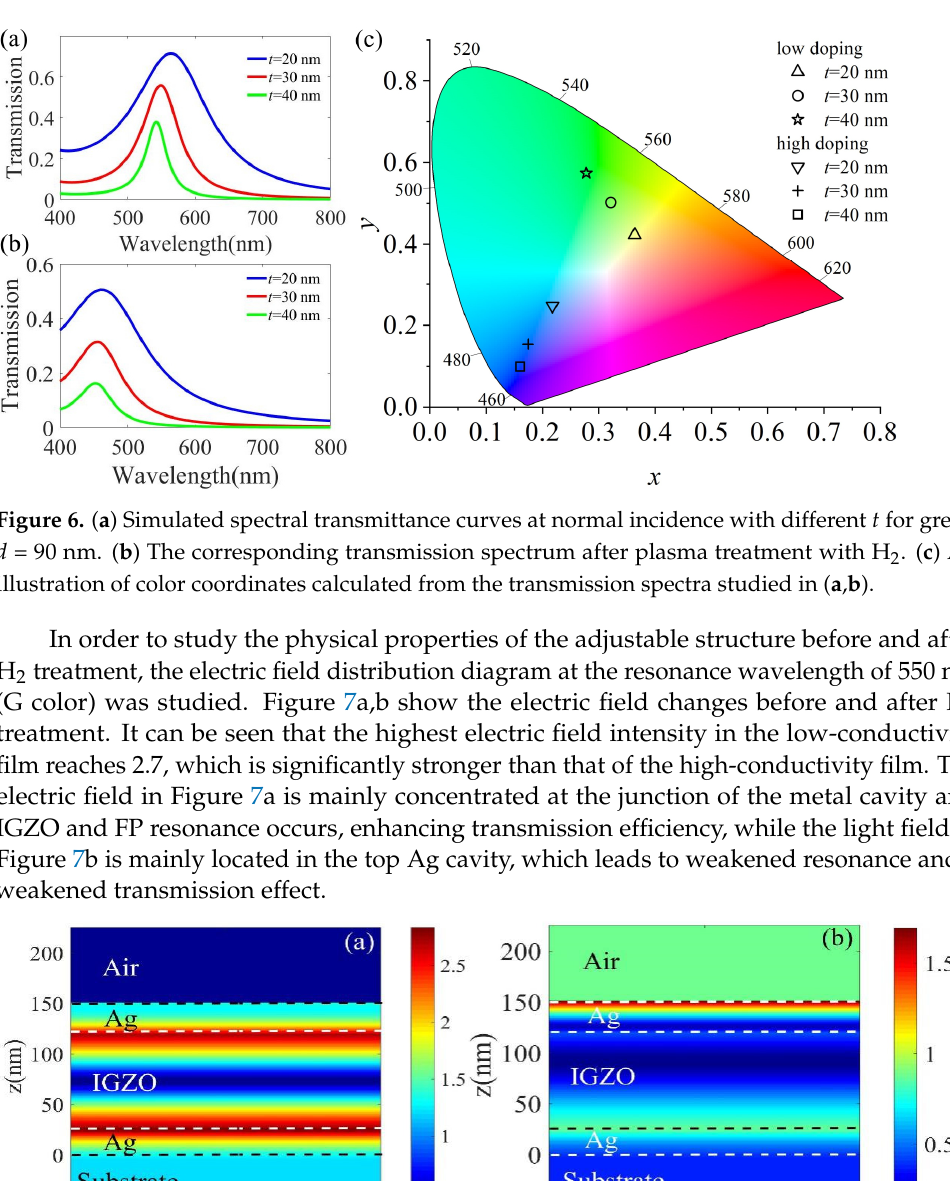
8 of 11 Figure 5. For TM polarization: ( a ) transmission spectra of different IGZO thicknesses before H 2 treat- ment and ( b ) after H 2 treatment. For TE-polarization: ( c ) transmission spectra of different IGZO thicknesses before H 2 treatment and ( d ) after H 2 treatment. The thickness of the metal layer reflector affects the transmission effect and the color produced. In the following, we study the effect of the metal layer thickness t on the trans- mission spectrum and color-rendering properties. Figure 6a depicts the change in the transmittance of RGB with the thickness of Ag at normal incidence when the filter presents the G color. As t increases, the transmission efficiency decreases and the resonance wave- length is red-shifted. Figure 6b shows the transmission spectrum after H 2 treatment; with the increase in t , the transmission efficiency also decreases, but the spectral response ad-